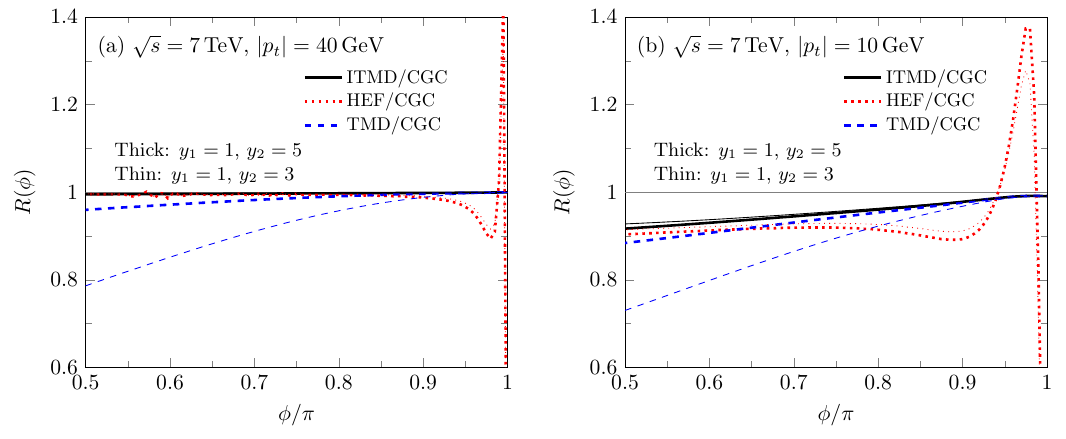
Figure 7 . The ratio R of ITMD/CGC (solid black line) for quark dijet production with ( y 1 , y 2 ) = (1 , 5) (thick) and (1 , 3) (thin) at (a): | p t | = 40 GeV and (b): 10 GeV in p + p collisions at Other notations are the same in figure